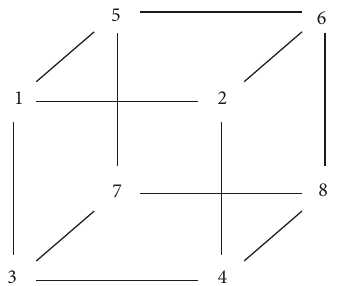
Figure 1: An example of cubes of order 2 but not magic.